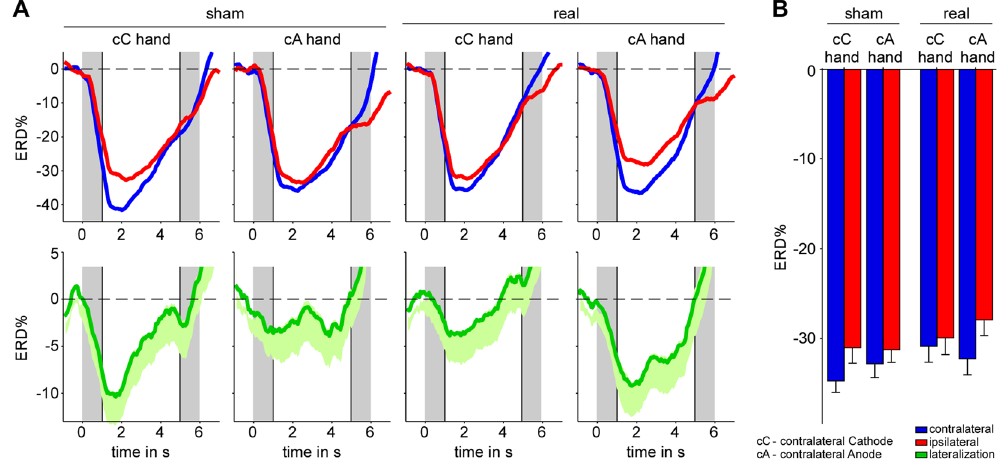
Figure 2. Descriptive statistics of stimulation-induced changes on neural level. ( A ) Grand average time course of MI-induced ERD% for the hand contralateral to the cathode (cC hand) and the hand contralateral to the anode (cA hand) separately for sham (left half) and real (right half) stimulation. For the sake of transparency contralateral ERD% and ipsilateral ERD% (top half) before calculating the ERD% lateralization (difference between contra- and ipsilateral ERD%, bottom half) used for the main analysis are also presented in this figure. Activity extracted above the contralateral and ipsilateral hemisphere, with respect to the hand used, is visualized in blue and red respectively. Activity was extracted from the scalp sites C3 and C4. The MI interval started at 0 s and ended at 5 s, however, as ERD% was derived using a moving average, the two grey shaded areas mark the time windows of begin and end of the MI interval. The two vertical lines indicate the time interval used for statistical analysis (0.5 s to 4.5 s) and the horizontal dashed line represents the zero line. For the ERD% lateralization the mean with standard error of the mean is illustrated. ( B ) MI-related activity extracted above the contralateral and ipsilateral hemisphere between 0.5 s to 4.5 s. Error bars represent one standard